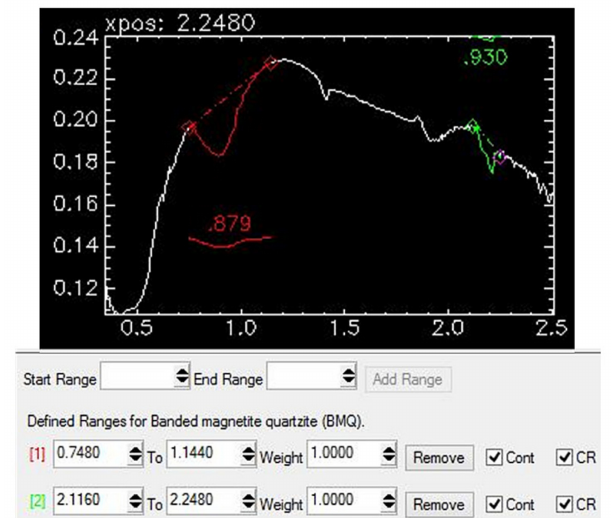
Figure 7. Graphical representation of how spectral range and other spectrometric parameters such as the width and depth of the diagnostic absorption features of each rock type are used to implement multi-range spectral feature fitting algorithm.